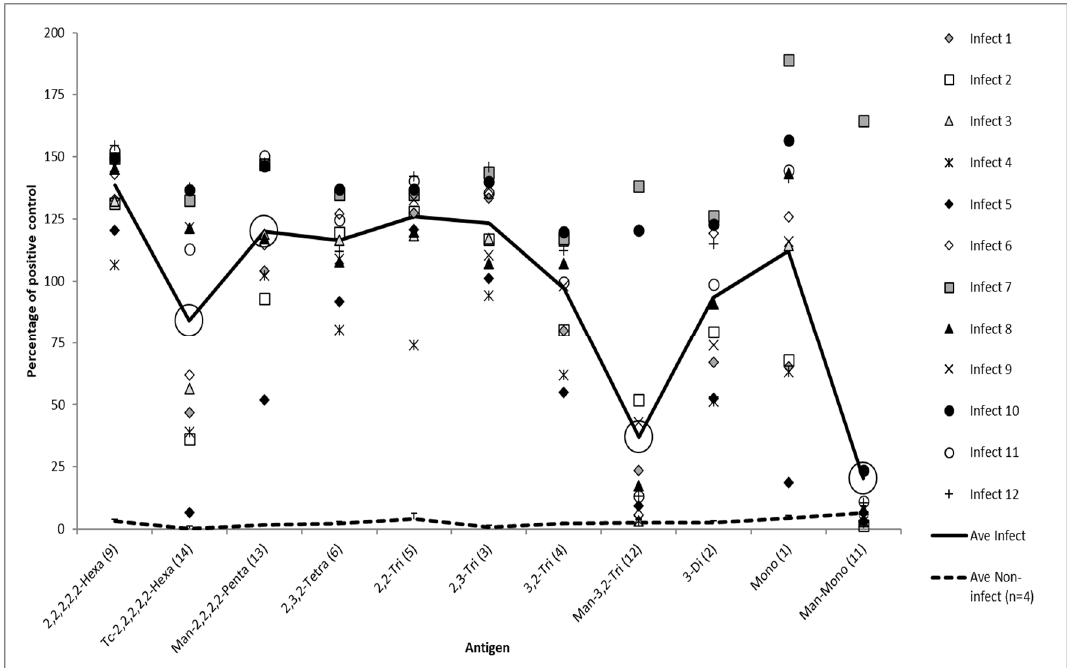
Figure 1. A line and dot plot showing synthetic oligosaccharide antigen structure (all squarate conjugates) on the x -axis and the cattle serum sample result, as a percentage of a common positive control sera against the 2,3,2-Tetra (6) antigen on the y -axis. The individual results for 12 serum samples, each tested for all antigens, are shown as individual icons (Infect 1–12). Samples 1–6 are from GB infected cattle and 7–12 are from Turkish infected cattle. The solid black line shows the average results for these 12 serum samples from infected cattle tested with 11 antigens. The dotted black line shows the average result of 4 serum samples from non-infected cattle (individual results not shown). The 11 antigens have been ordered along the x -axis according to size, with larger antigens, hexasaccharides, at the left end of the x -axis and smaller antigens, monosaccharides, on the right. The data from the antigens that are capped (all are mannose caps) are highlighted by large circles that surround the average result for the antigen.